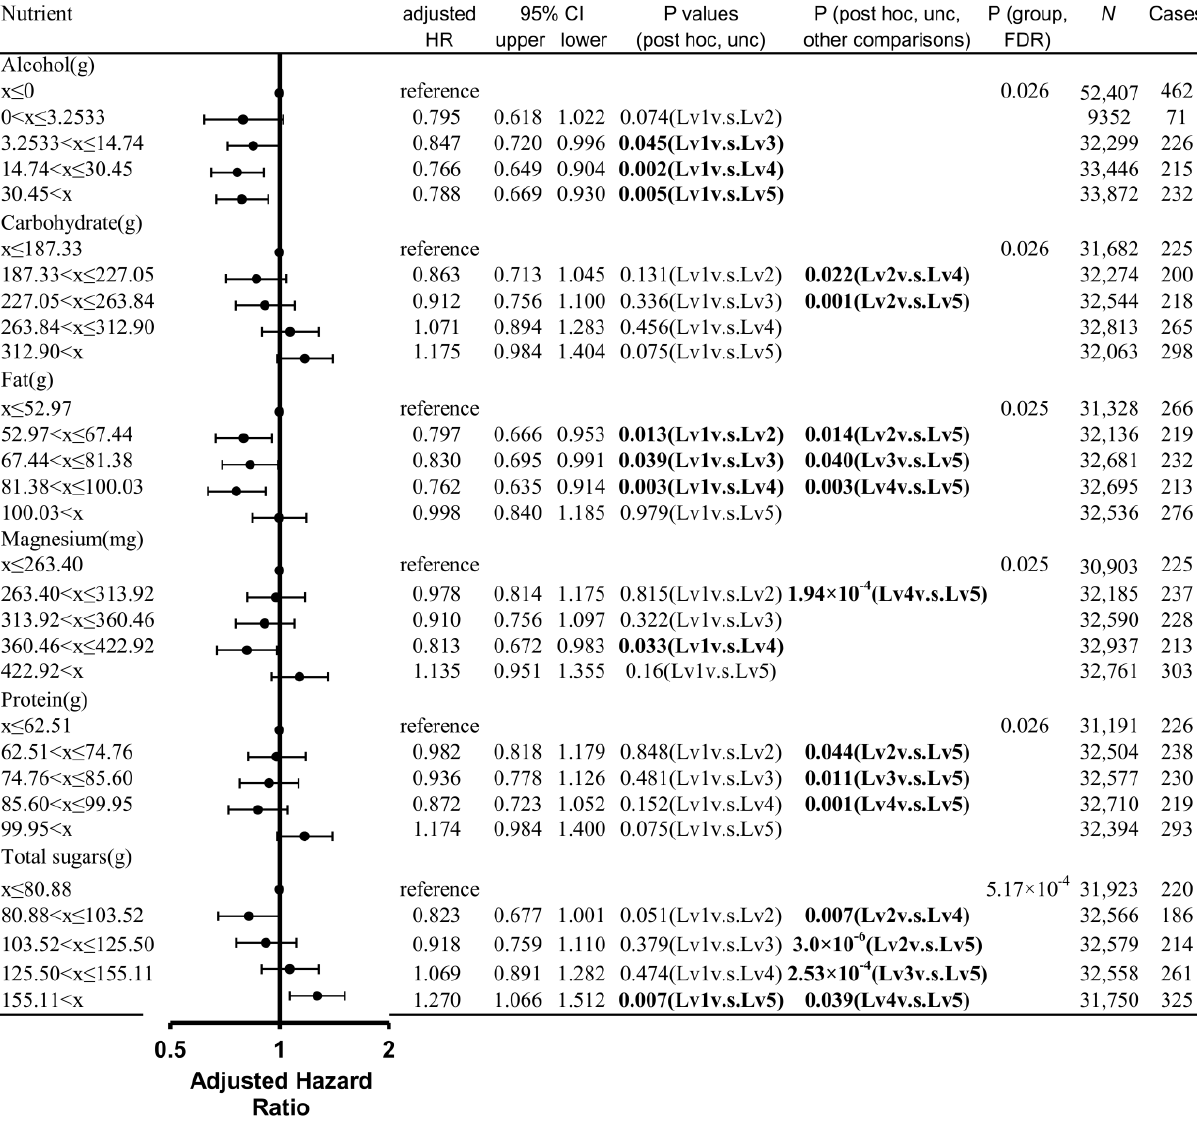
Figure 1. Standardized risks of incident dementia over time according to the intake level of each nutrient (alcohol, carbohydrate, fat, magnesium, protein, and total sugars). Cox proportional hazards models were adjusted for potential confounding variables. The adjusted hazard ratios of each intake level group, compared with the group with the lowest intake level and their 95% confidence intervals, are provided. The p values of overall group difference (p (group)) and post hoc comparisons between each group as well as the size of the entire group and the dementia cases included in each group are shown. Bold = p < 0.05.